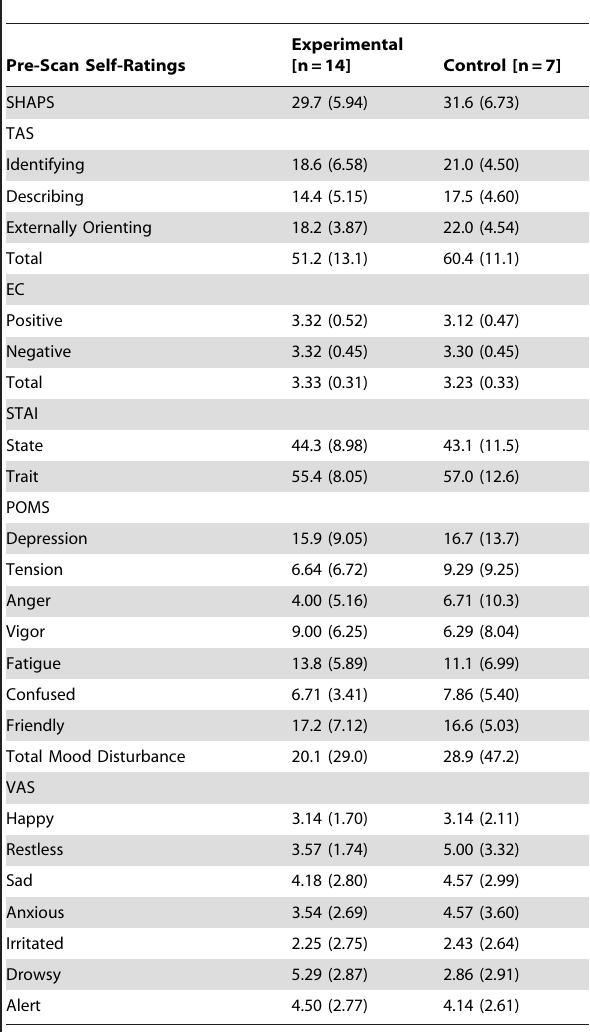
Table 2. Pre-Scan Mood Ratings for each experimental